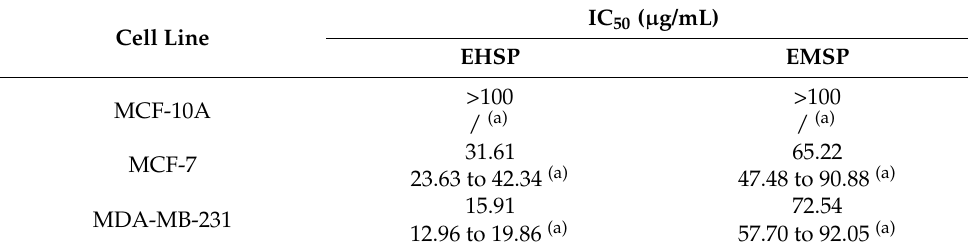
Table 3. Cytotoxic activity of n -hexane (EHSP) and methanol (EMSP) extracts. Cell